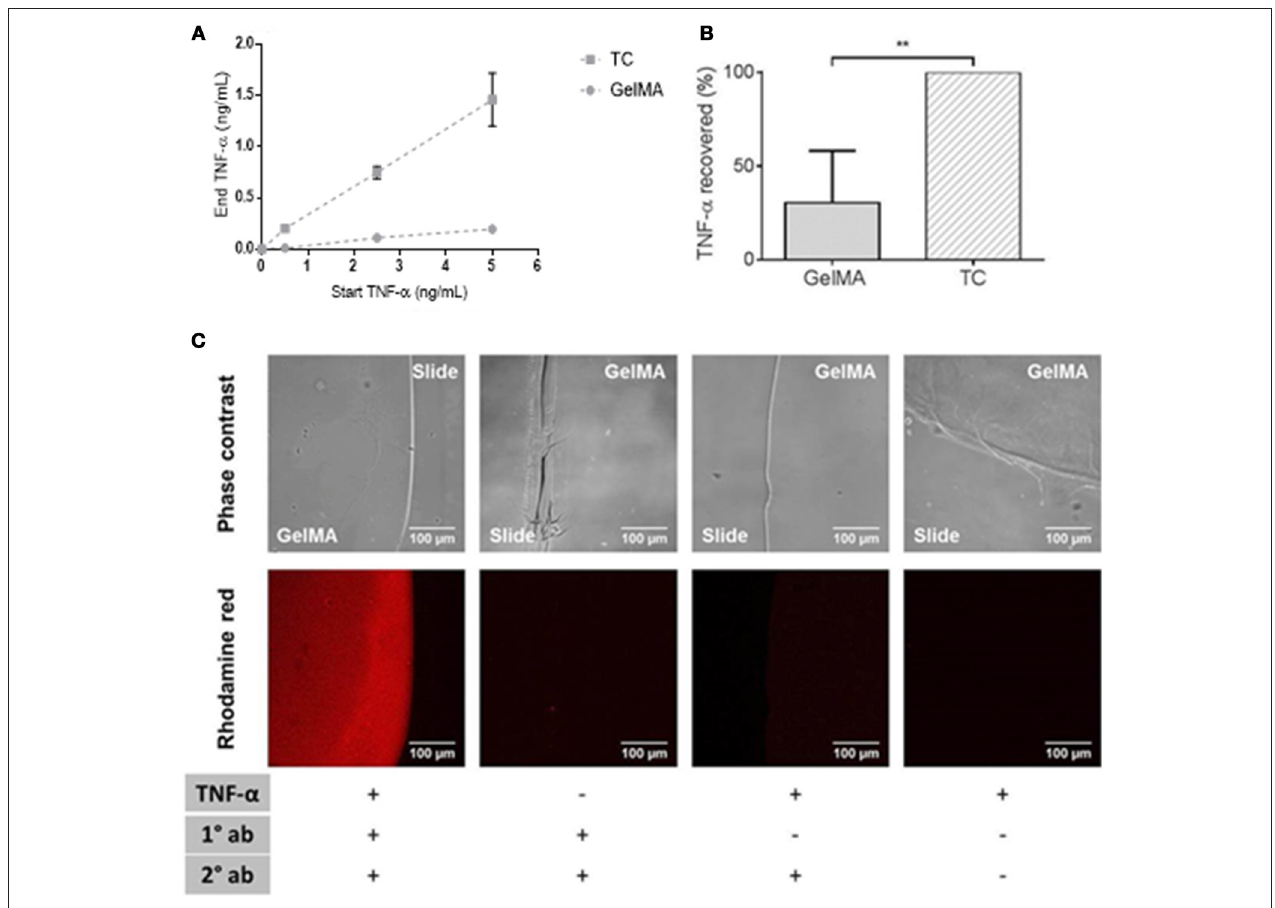
FIGURE 4 | Depletion of soluble TNF- α by GelMA hydrogels. (A) Residual TNF- α detected after incubation of GelMA hydrogels in media containing 0.5, 2.5, and 5ng/mL recombinant TNF- α . Error bars represent standard error of the mean. (B) TNF- α recovered from TC (100%) and GelMA (30%), a significant reduction in residual TNF- α recovered from GelMA was found relative to TC (** P = 0.0006). A two-tailed t -test was performed to determine statistical significance ( n = 3 independent experiments). Error bars represent standard deviation. (C) TNF- α -treated GelMA, labeled with mouse anti-human TNF- α (primary) and rhodamine red goat anti-mouse (secondary) antibodies. Untreated GelMA, stained with primary and secondary antibodies. GelMA, secondary antibody control. GelMA, unlabelled. Images acquired on an LSM710 META Zeiss confocal system, using a 20X objective. Scale bars represent 100 µ m.